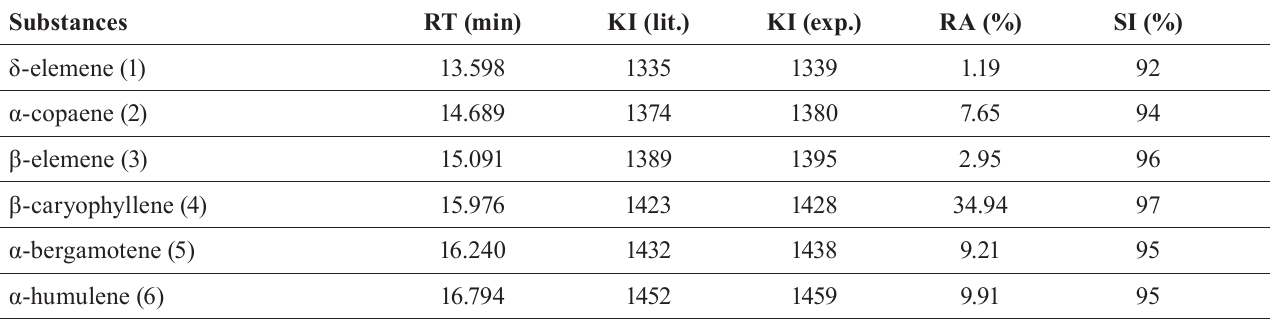
TABLE I - C hemical composition of copaiba oil identified by GC-MS